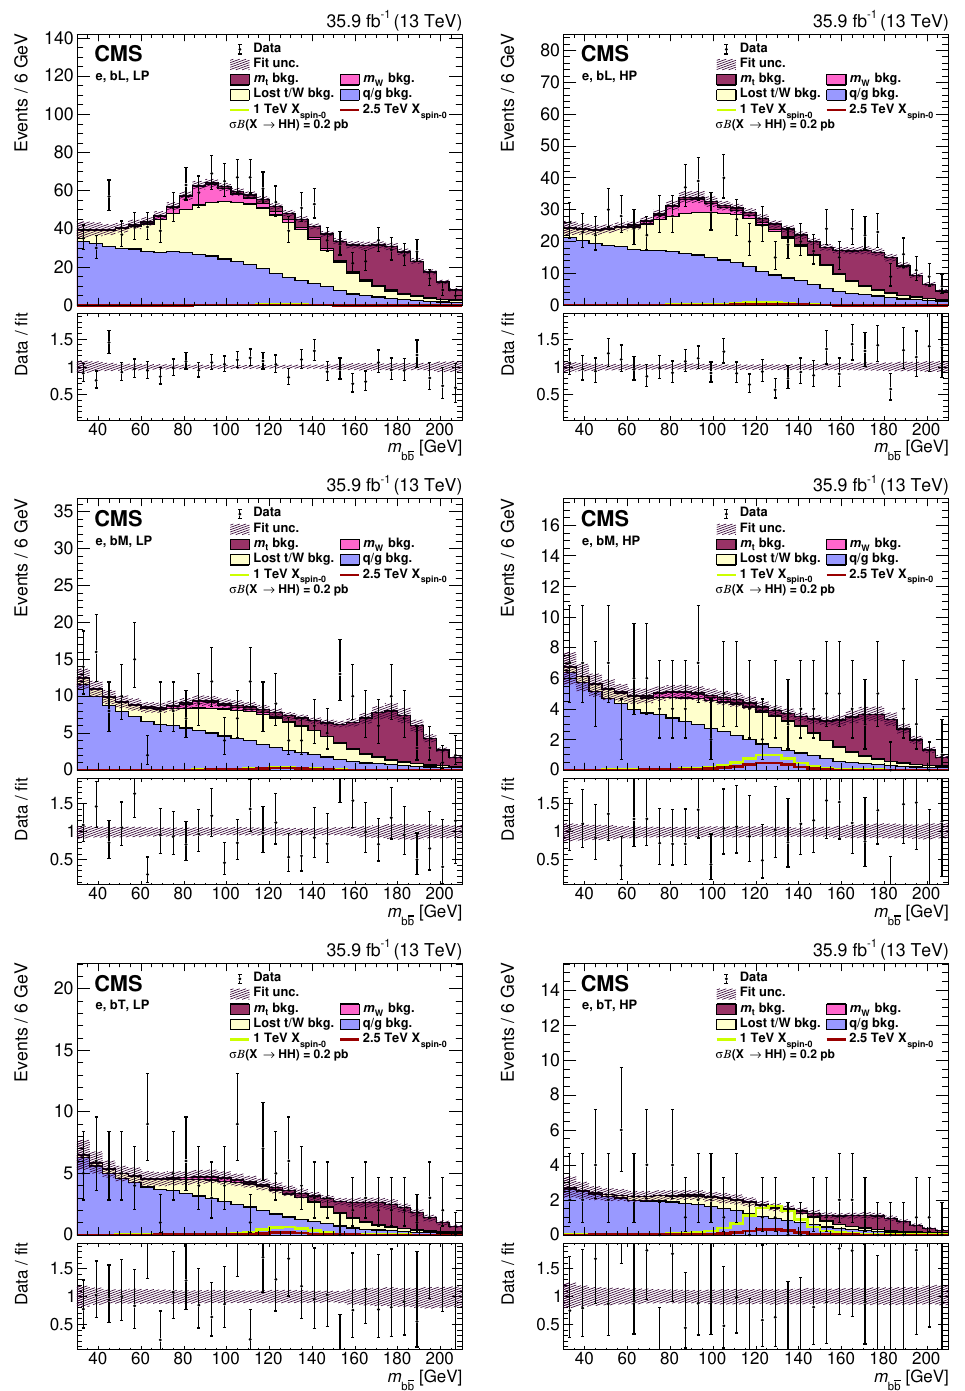
Figure 3 . The (cid:12)t result compared to data projected in m for the electron event categories. The bb (cid:12)t result is the (cid:12)lled histogram, with the di(cid:11)erent colors indicating di(cid:11)erent background categories. The background shape uncertainty is shown as the hatched band. Example spin-0 signal distribu- tions for m of 1 and 2.5 TeV are shown as solid lines, with the product of the cross section and X branching fraction to two Higgs bosons set to 0.2 pb. The lower panels show the ratio of the data to the (cid:12)t